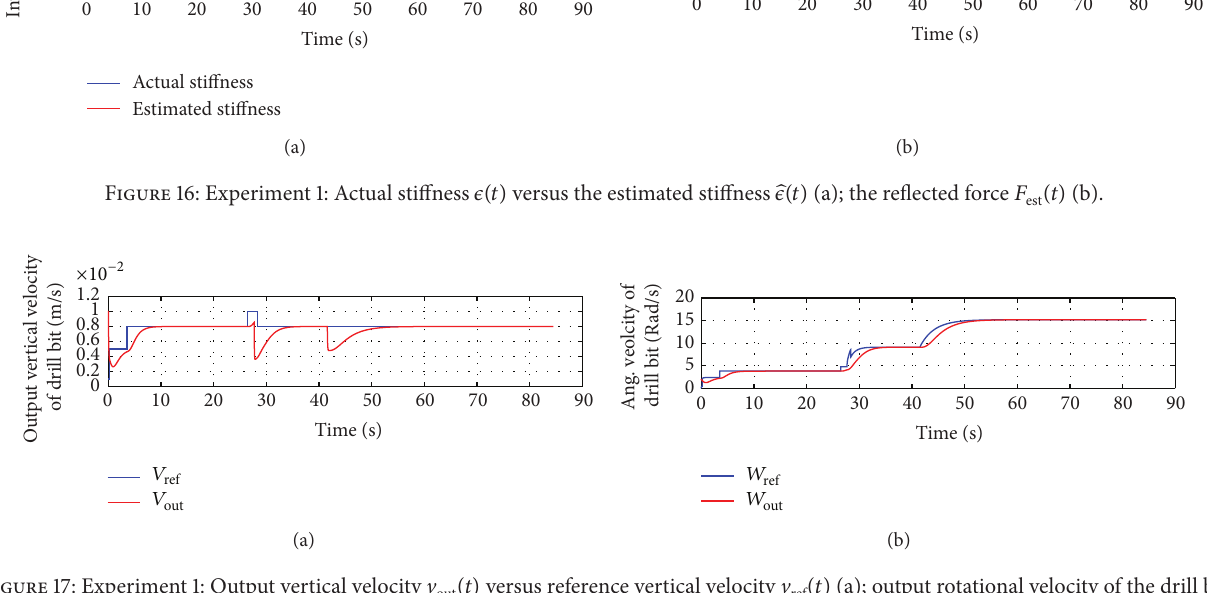
Figure 17: Experiment 1: Output vertical velocity V (𝑡) versus reference rotational velocity 𝜔 𝜔 1